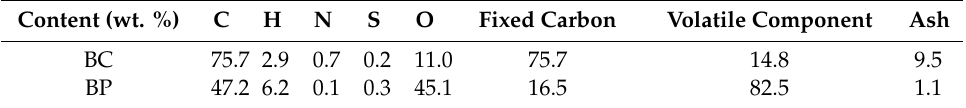
Table 2. Chemical composition of BC and